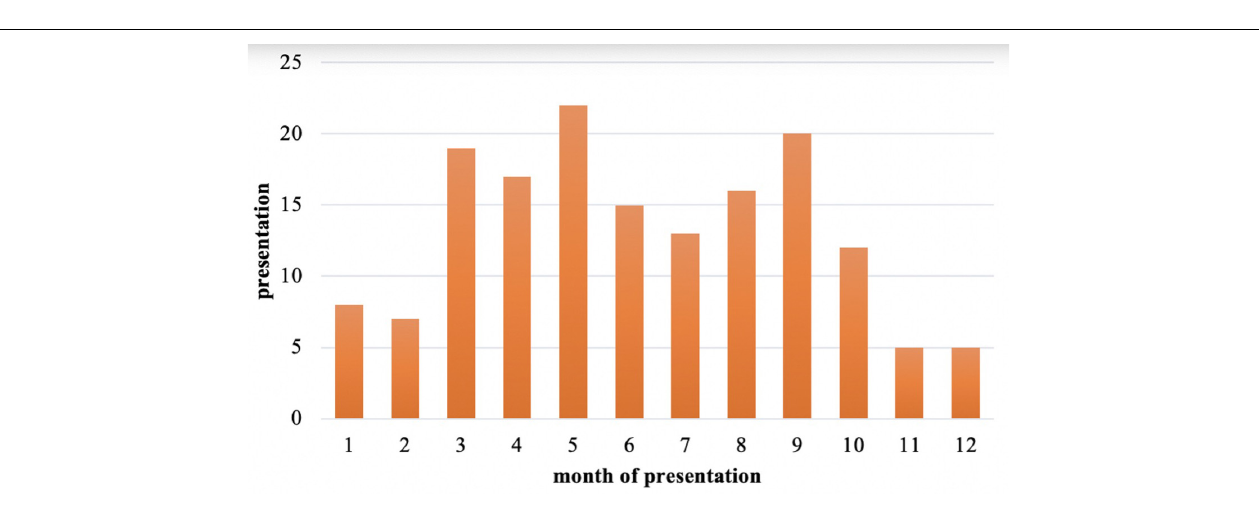
FIGURE 5 | The monthly incidence of acute hepatitis E infection from January 2020 to October